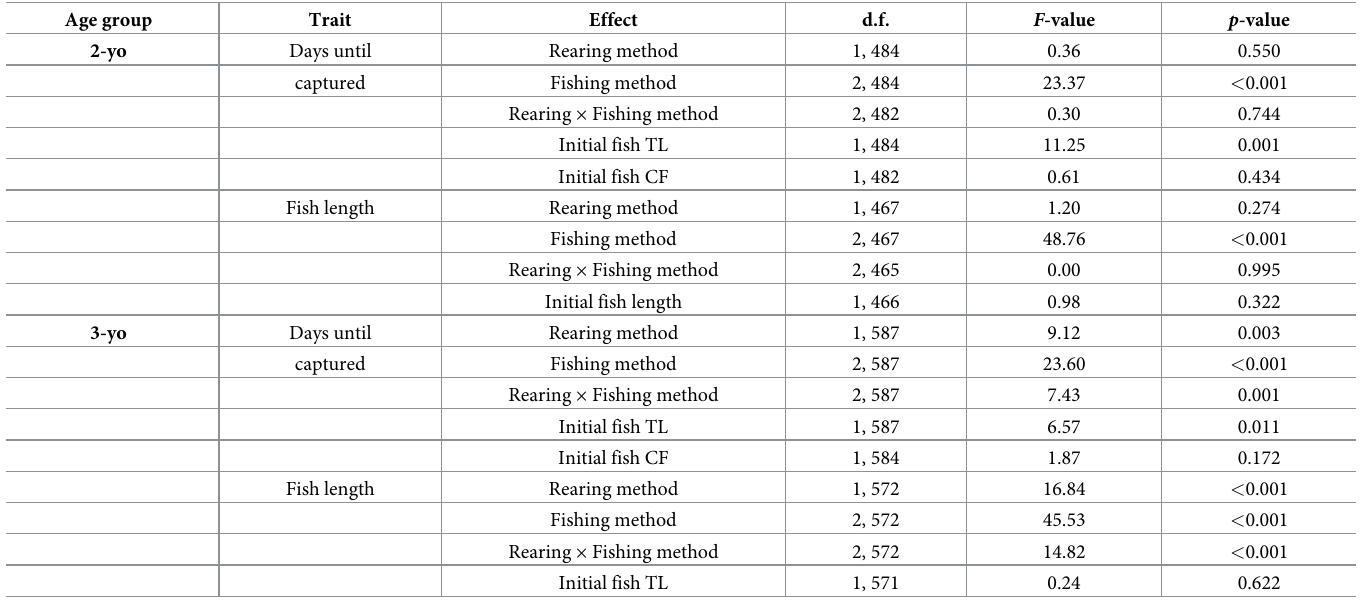
Table 5. Results from statistical tests concerning the effects of rearing method, fishing method category, and initial fish length (at tagging; TL) and condition fac- tor a (CF) on time (days post-release) and fish length at capture in 2- and 3-yo salmon. Insignificant interaction and covariate terms were excluded from the final models.